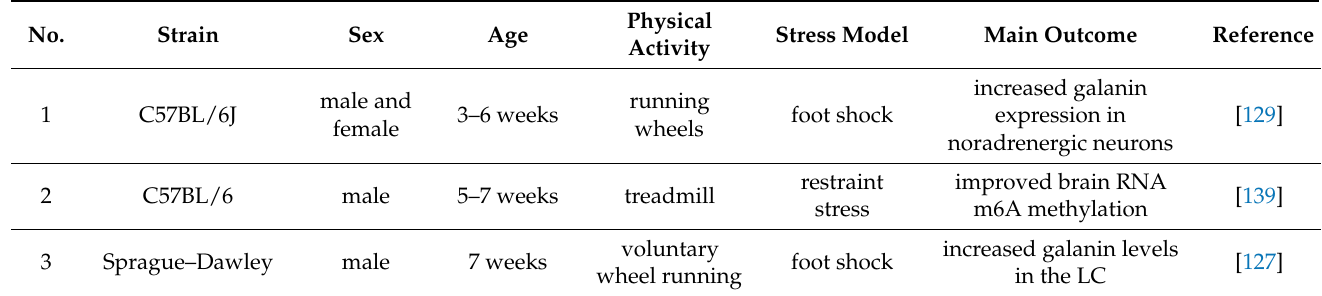
Table 6. Summary of animal research focusing on galanin system and RNA